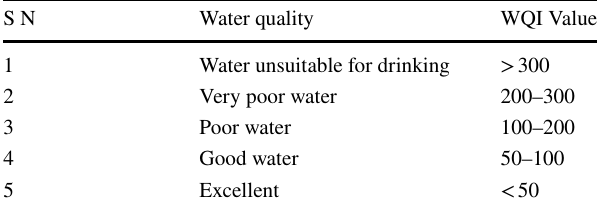
Table 2 Classification water quality index based on WQI value S